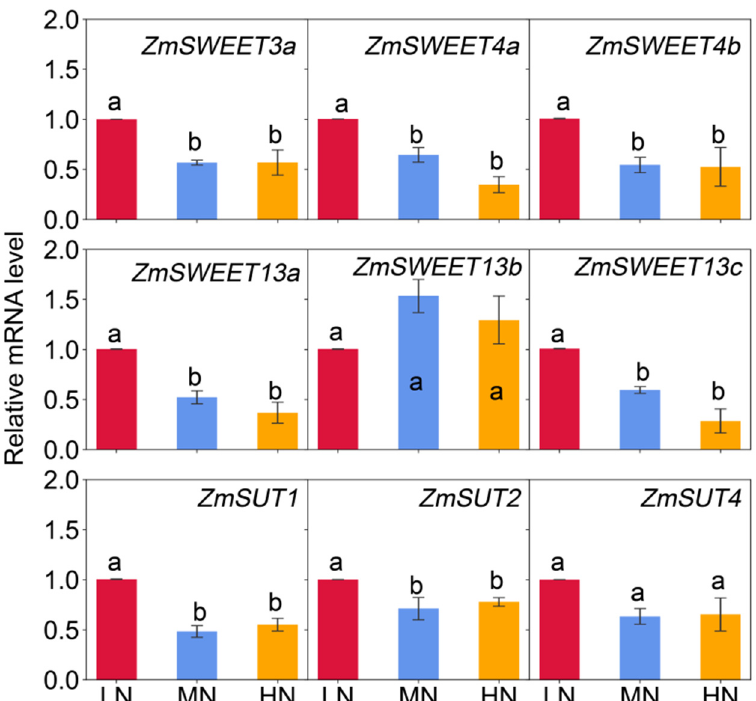
Figure 7. The relative expression level of genes involved in sugar transport in leaves at 62 days after sowing. Columns with no letter in common are significantly different between nitrogen treatments in each panel ( p < 0.05). Vertical bars indicate the standard error of the mean ( n = 4).